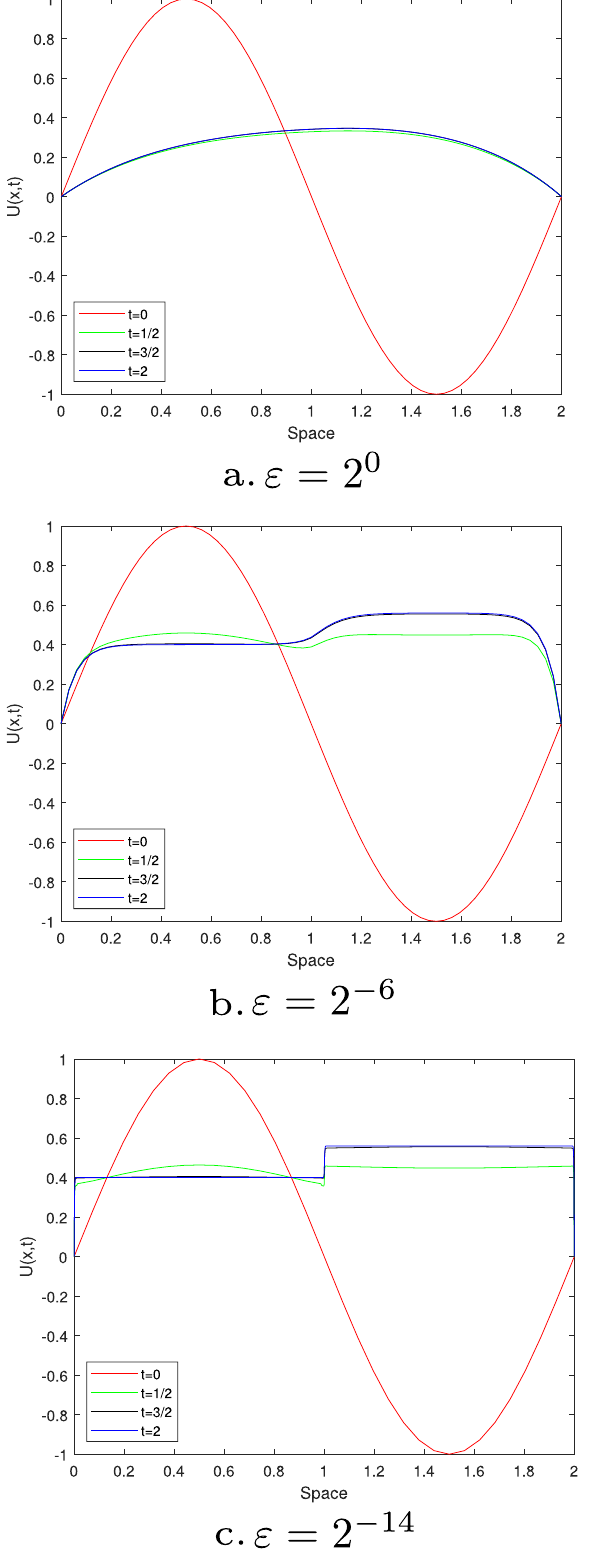
Fig. 4 Simulations for the numerical solution of Example 2, taking 𝜃 =0.5, 𝛽 =1.5, N =64 and M =32 at different time levels and perturbation parameters (surface